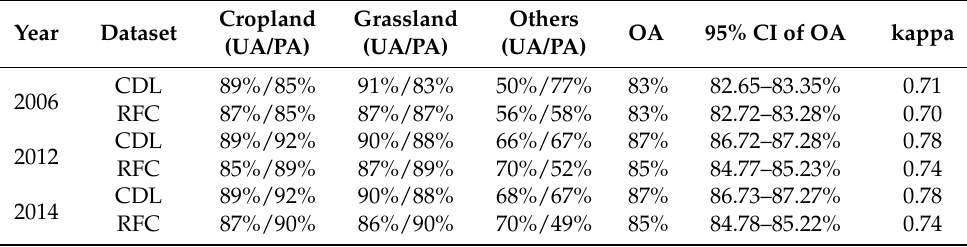
Table 1. Accuracy assessment of CDL and RFC (this study) using the reference point dataset [3]. OA